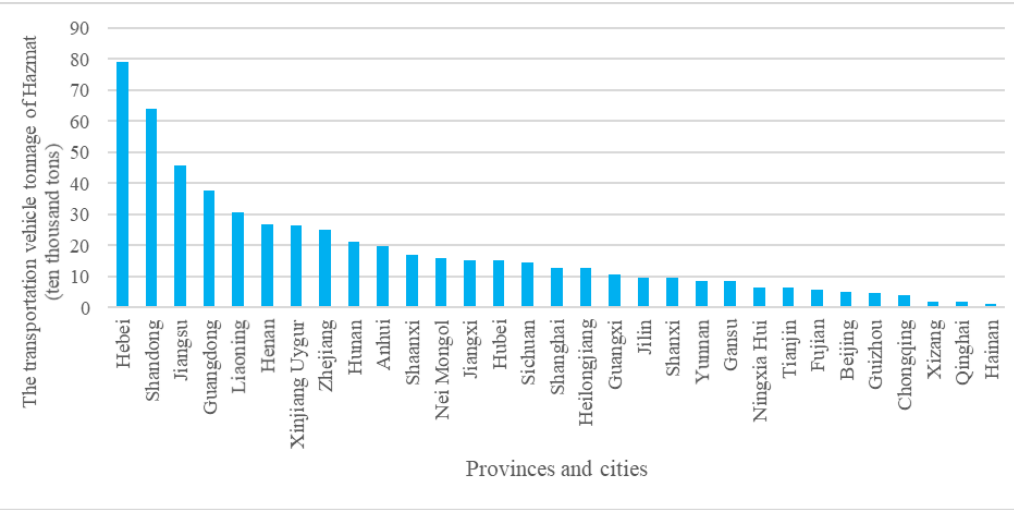
Figure 1. Spatial distribution of Hazmat transportation accidents by provinces.